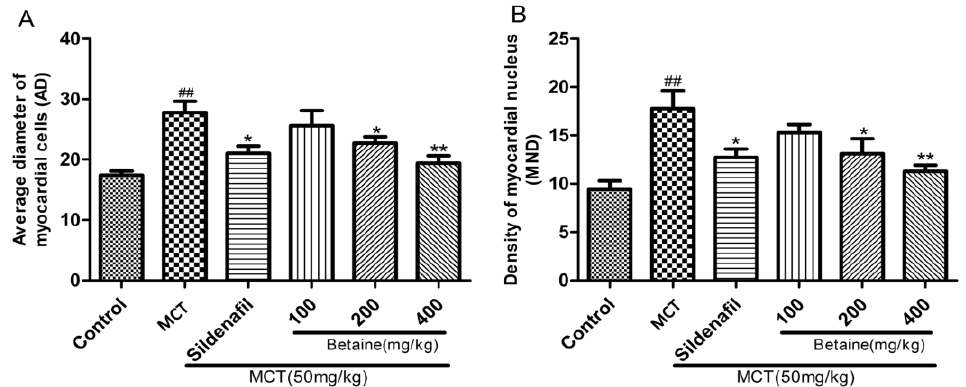
Figure 5. ( A) Effects of betaine on right ventricle remodeling and ( B) Average diameter (AD) of myocardial cells and myocardial nuclear density (MND). Data are shown as mean ± standard error of the mean ( n = 6). ## p < 0.01 vs. control group, * p < 0.05, ** p < 0.01 vs. MCT group. MCT: MCT-induced group.